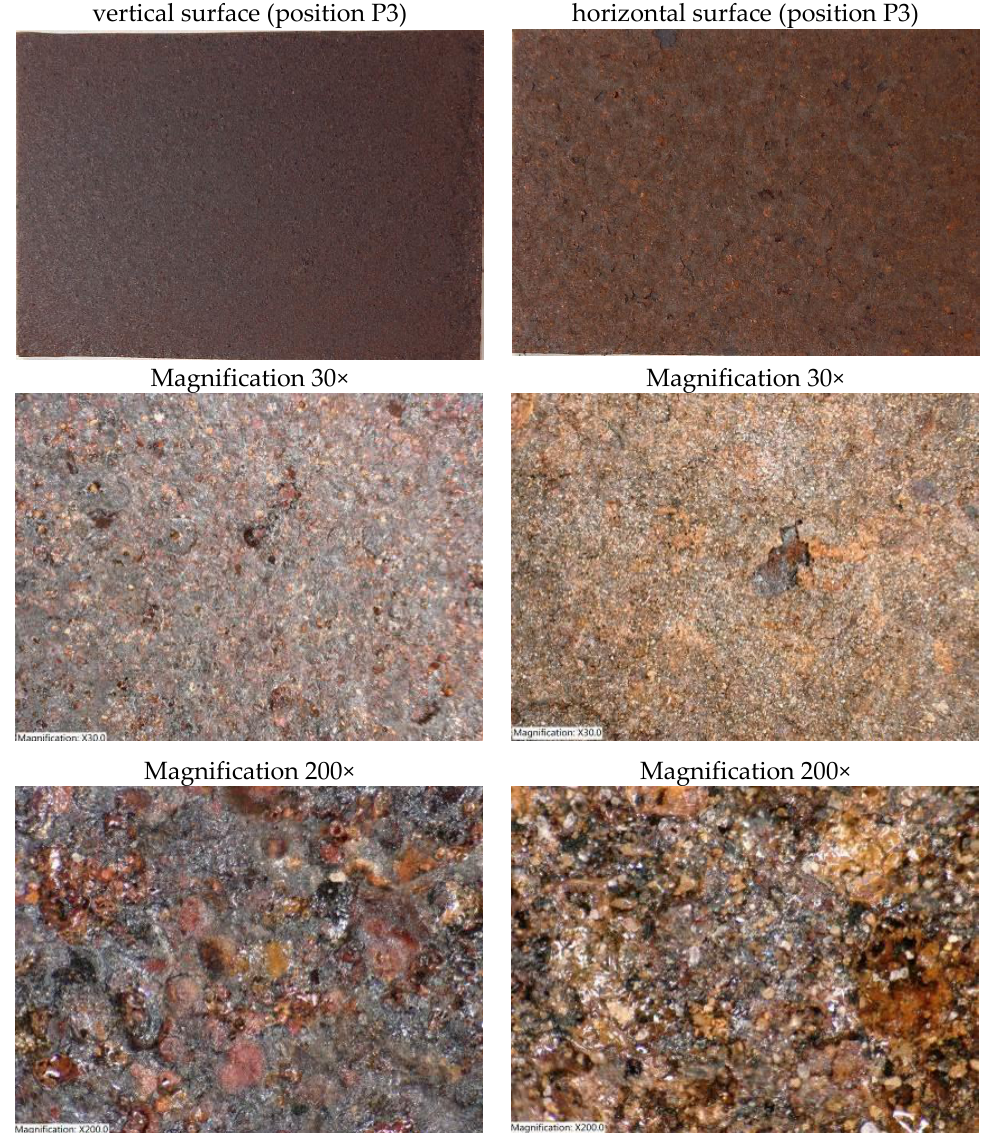
Figure 6. Bridge B1, position P3 — layer of corrosion products on the surfaces of exposed samples after one year of exposure.